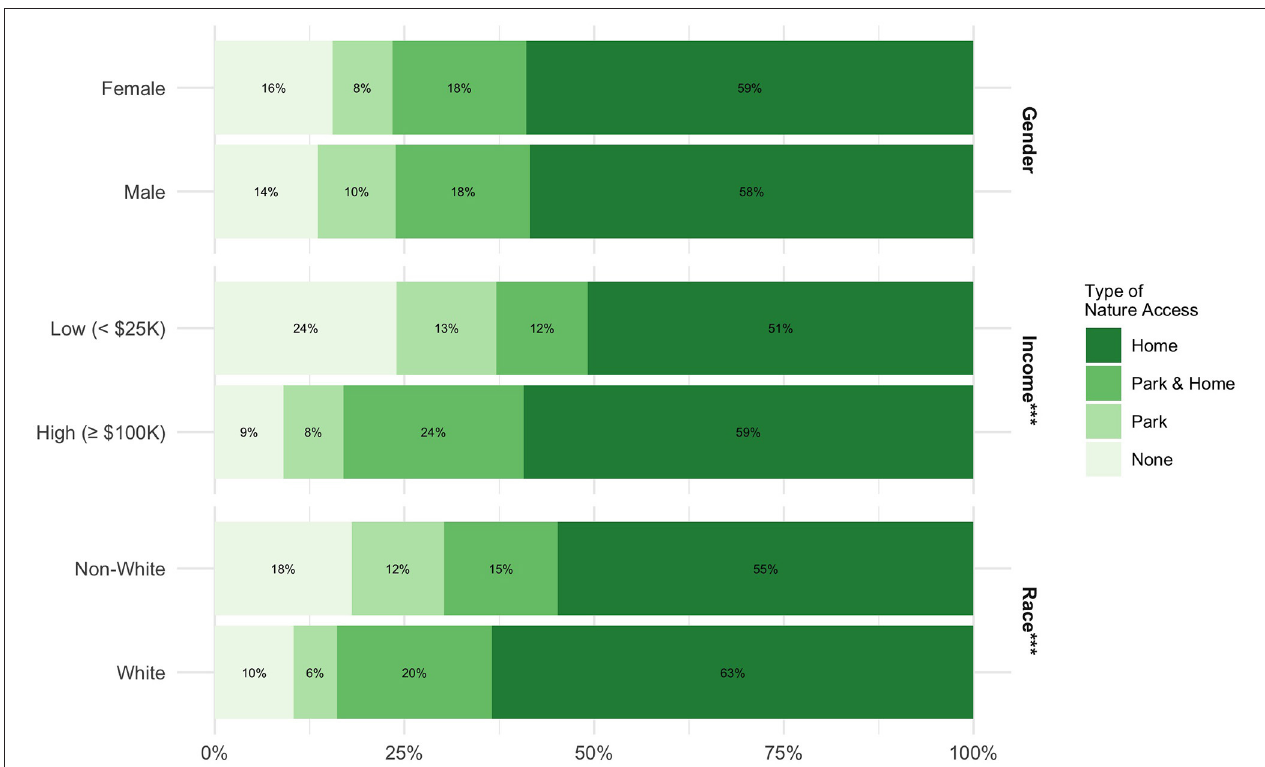
FIGURE 4 | Type of nature access during the pandemic by demographic group. None indicates not spending time in nature; Park indicates just time in public parks or natural areas; Park and Home indicates time in both public and private natural areas; and Home indicates just time in a private yard or garden. Significance is from chi-squared tests within demographic groups. *** p <